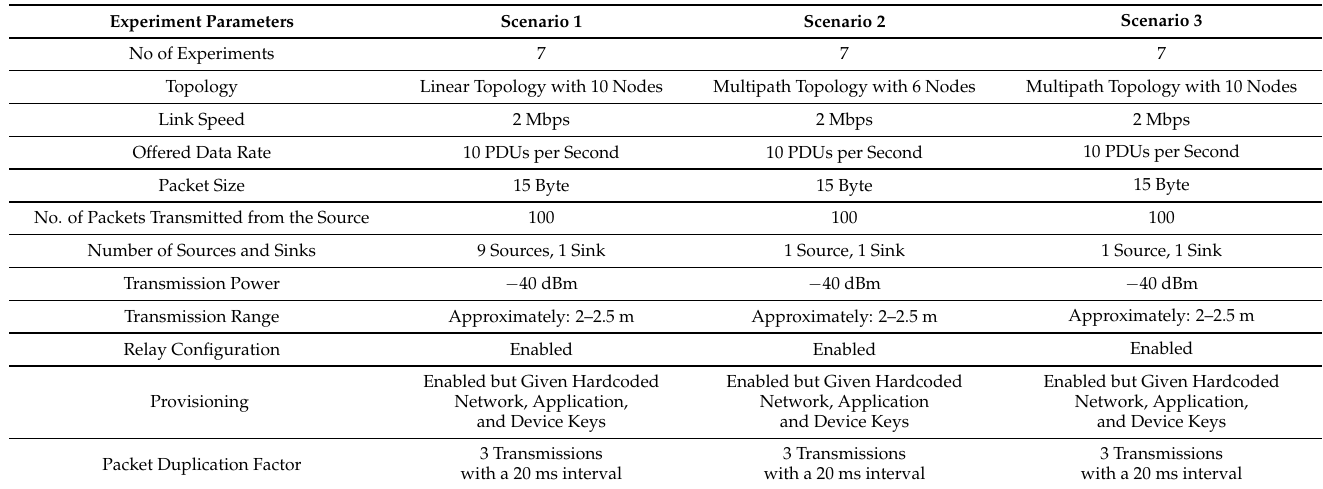
Table 2. Common experiment setup and configurations.